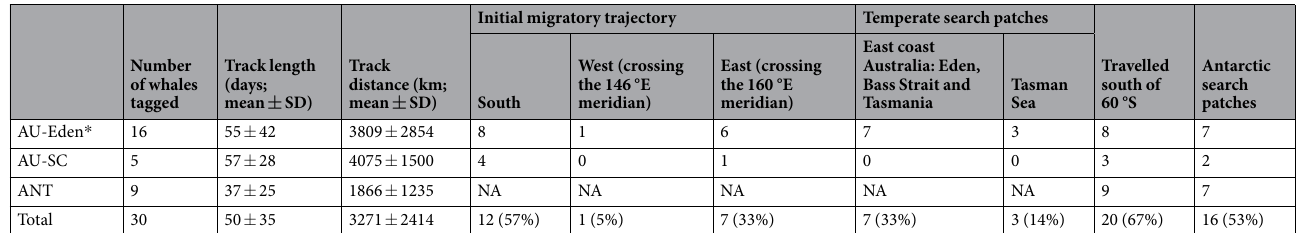
Table 2. Summary movement statistics for thirty satellite tracked humpback whales. Numbers indicate individual animals, with percentages (%) given in parentheses. Trajectory and temperate search patch statistics apply only to whales tagged off Eden and Sunshine Coast, Australia. * One tag failed before transmitting a clear migratory